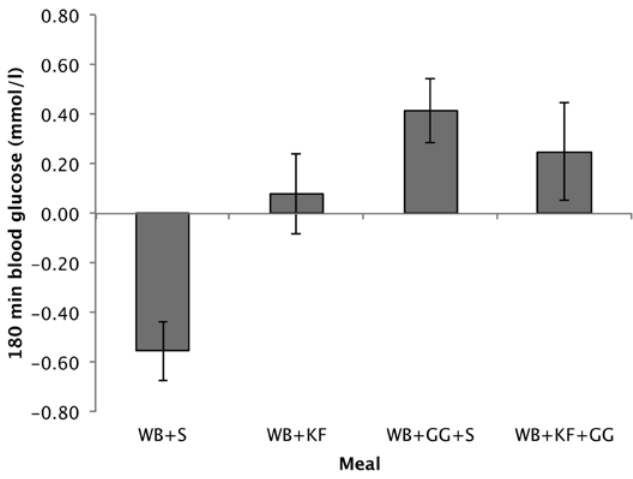
Figure 6. Blood glucose concentrations at 180 min after consuming wheat biscuit+sugars (WB+S), WB+kiwifruit (WB+KF), WB+guar gum+sugars (WB+GG+S), and WB+KF+GG. (Means ± sem; LSD 0.347, p < 0.001).